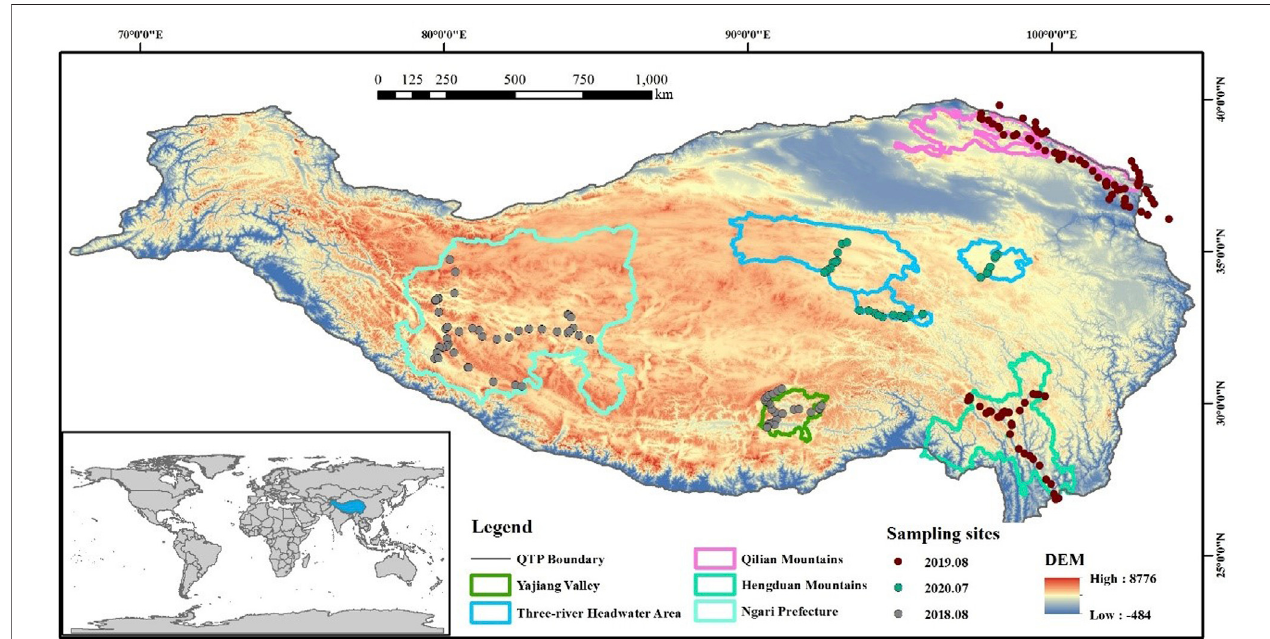
FIGURE 1 | Location of sampling sites in QTP (data source: http://data.tpdc.ac.cn).